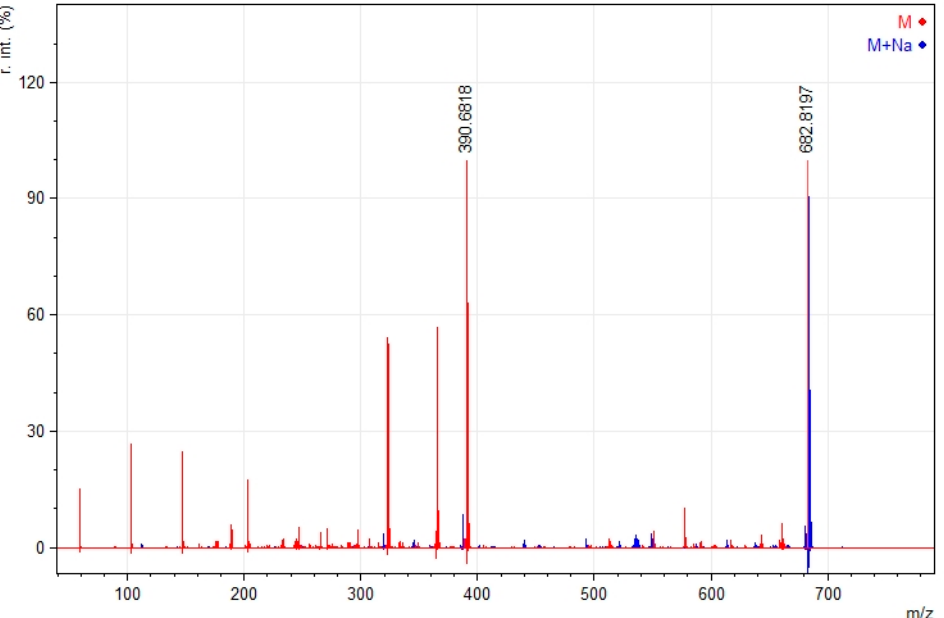
Figure 5. Mass spectrum of compound 5 with the presentation of fragmentations; [M+Na] + sodium adduct with molecular ion in blue, and [M] + molecular ion in red.